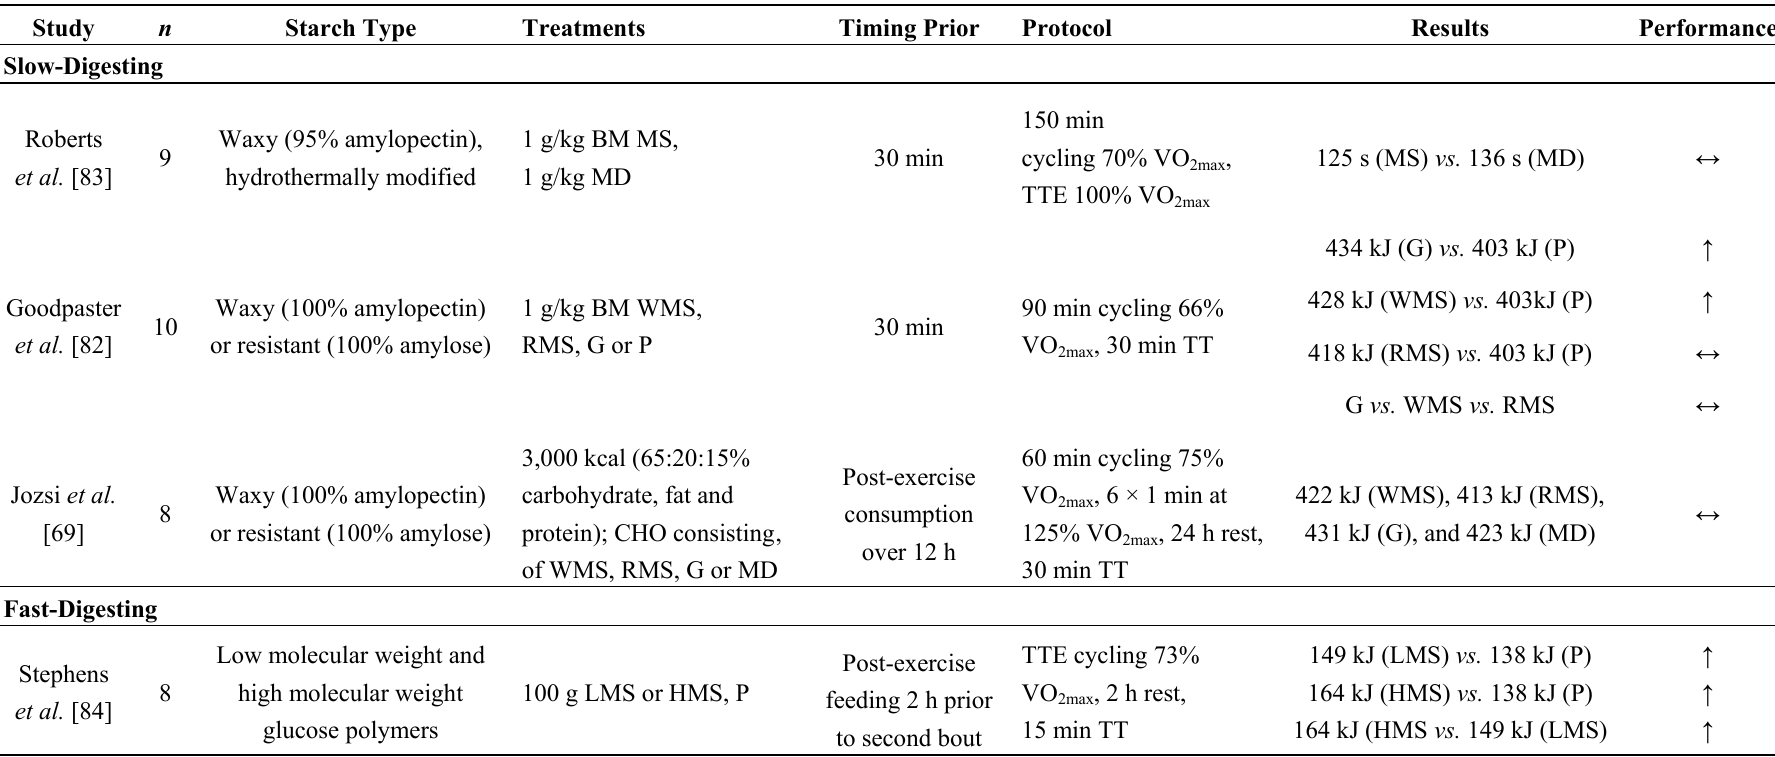
Table 2. The effect of pre-exercise or refeeding of modified and resistant starches on endurance performance. Study Protocol